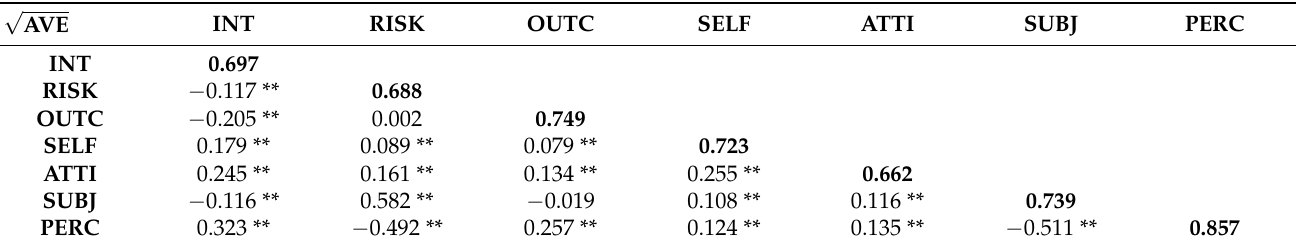
Table 5. Correlations between constructs and discriminant